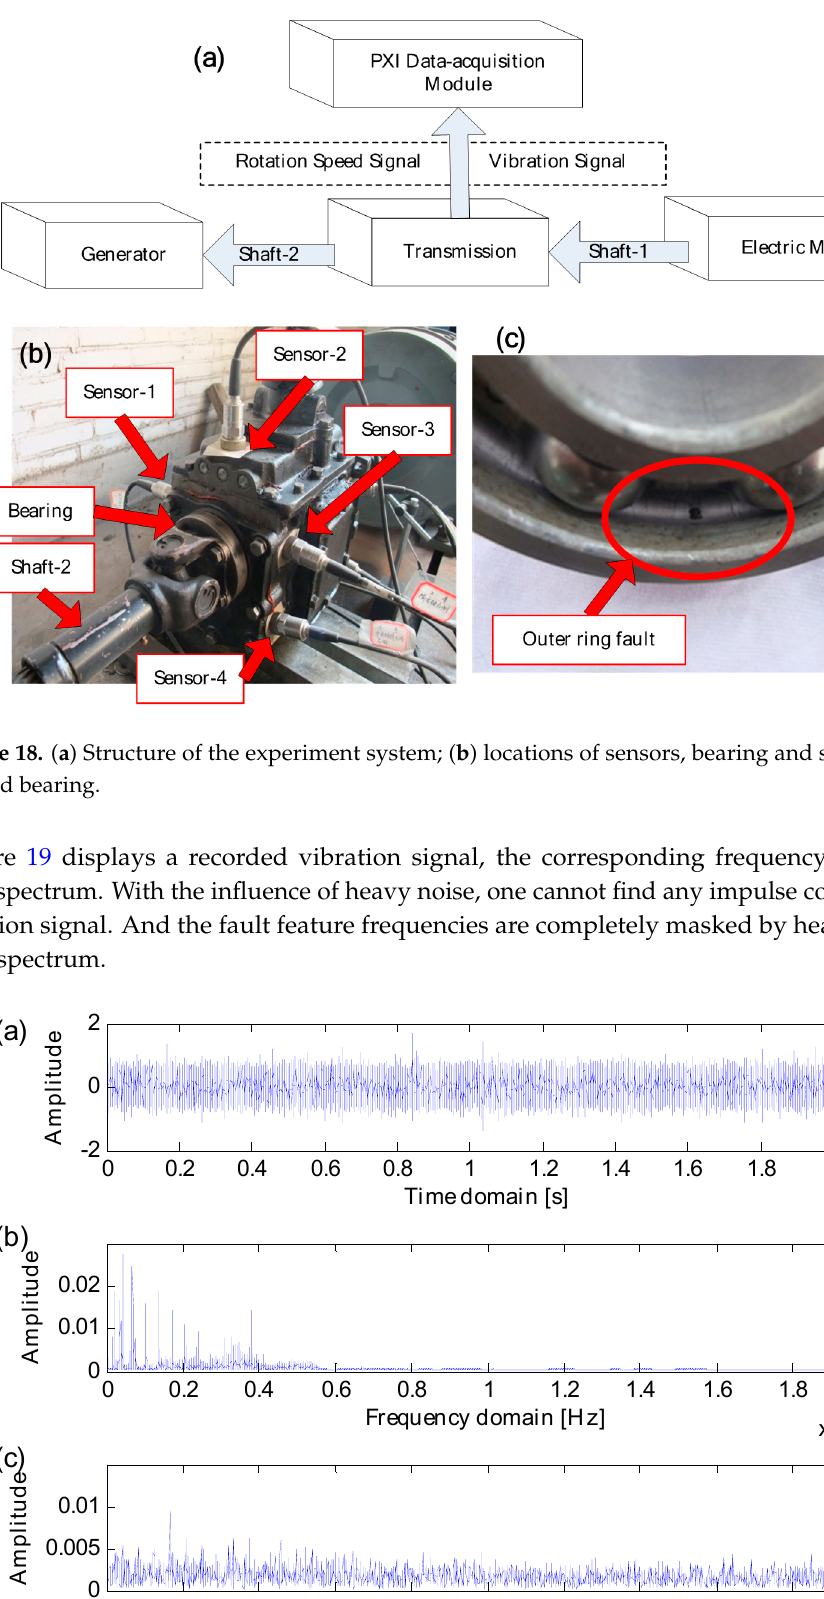
Figure 19. ( a ) Vibration signal; ( b ) frequency spectrum; ( c ) envelope spectrum.